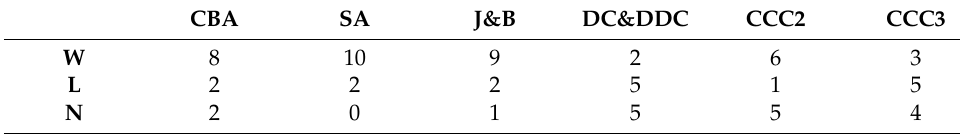
Table 7. Statistically significant wins/losses counts of CCC1 method on number of rules.